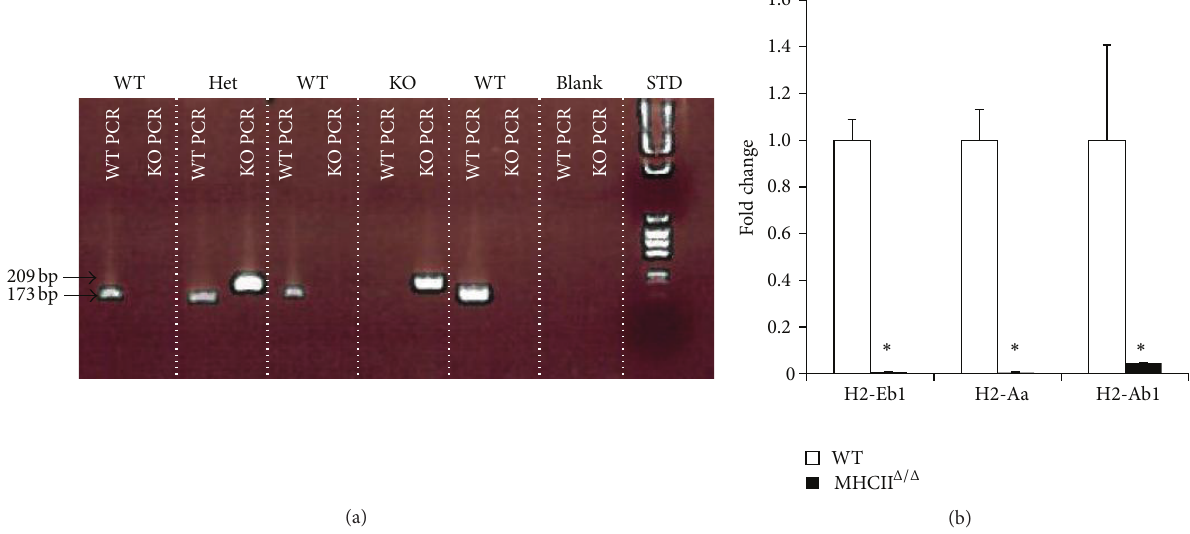
Figure 1: MHCII gene genotyping and hepatic expression in wild-type and MHCII Δ/Δ mice. (a) Two different PCRs were performed for the detection of wild-type (WT PCR) and knockout (KO PCR: MHCII Δ/Δ ) fragments; 173 bp for a WT band and 209 bp for a KO band. Therefore heterozygous (Het) presents both bands. (b) Gene expression of MHC II genes (H2-Eb1, -Aa, -Ab1) in liver samples by real-time RT-PCR. The expression was normalized by 𝛽 2 microglobulin and compared to the wild-type. Open bars represent wild-type and closed bars MHCII Δ/Δ mice ( 𝑛 = 10–14/group). Data are presented as mean ± SEM. ∗ Significantly different from wild-type mice, 𝑃 < 0.05 (Student t